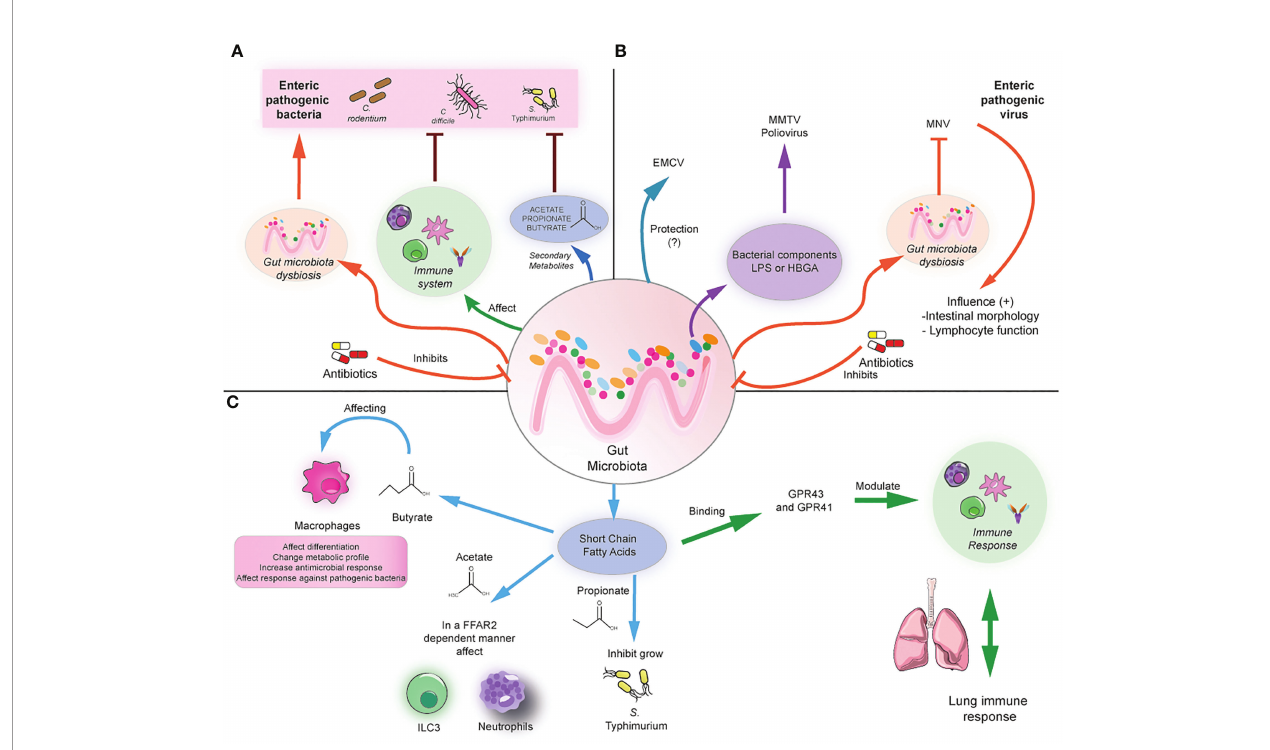
FIGURE 1 | Modulation of local and distal infection by the gut microbiota. (A) The gut microbiota can prevent enteric infection by modulating the immune cell responses and/or the production of secondary metabolites such as SCFA. In contrast, antibiotics induce gut microbiota dysbiosis, causing susceptibility to bacterial enteric infection. (B) The gut microbiota can affect the infection with enteric viruses differently, depending on the virus. For example, it could play a protective role in the case of ECMV, but it may promote the infection with MMTV and poliovirus by the binding with bacterial components and subsequent facilitation of viral infection. In antibiotic-treated mice, MNV can compensate for the bene fi cial effects of the gut microbiota by promoting anti-in fl ammatory responses. (C) The gut microbiota can produce SCFA, which in turn can modulate macrophages directly, ILC3, and neutrophil function by binding through the GRP41/43 receptors. In addition, SCFA can directly inhibit bacterial growth. In addition, SCFA can distally modulate lung immune